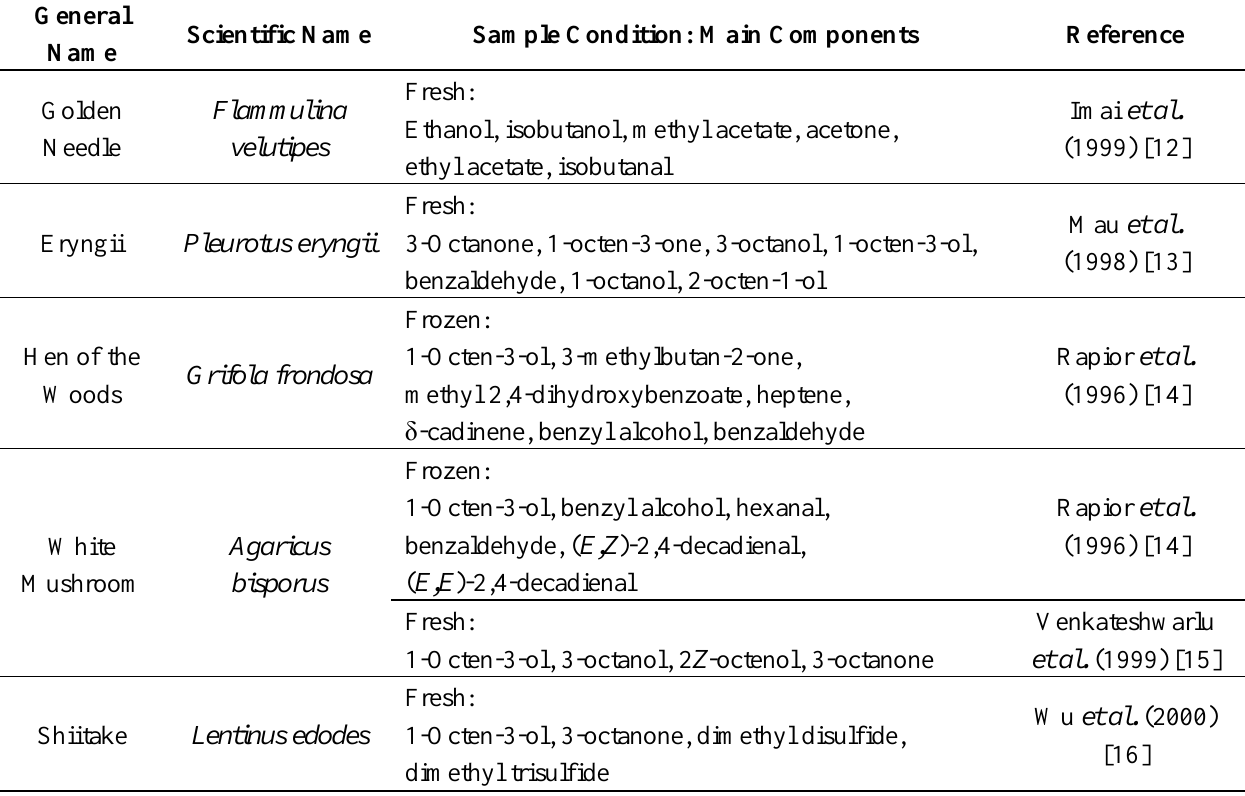
Table 1. Main Volatile Components of Mushrooms in